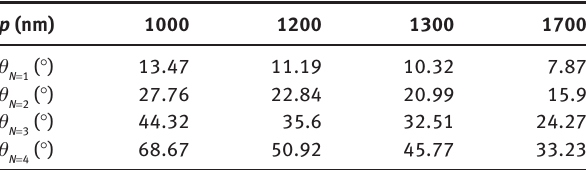
Table 1: Deflection angles ( θ device layer at different periods ( p ) and orders ( N